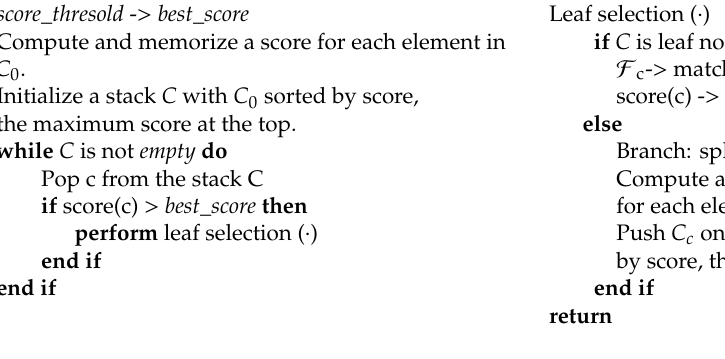
Table 3. Depth first search branch and bound scan